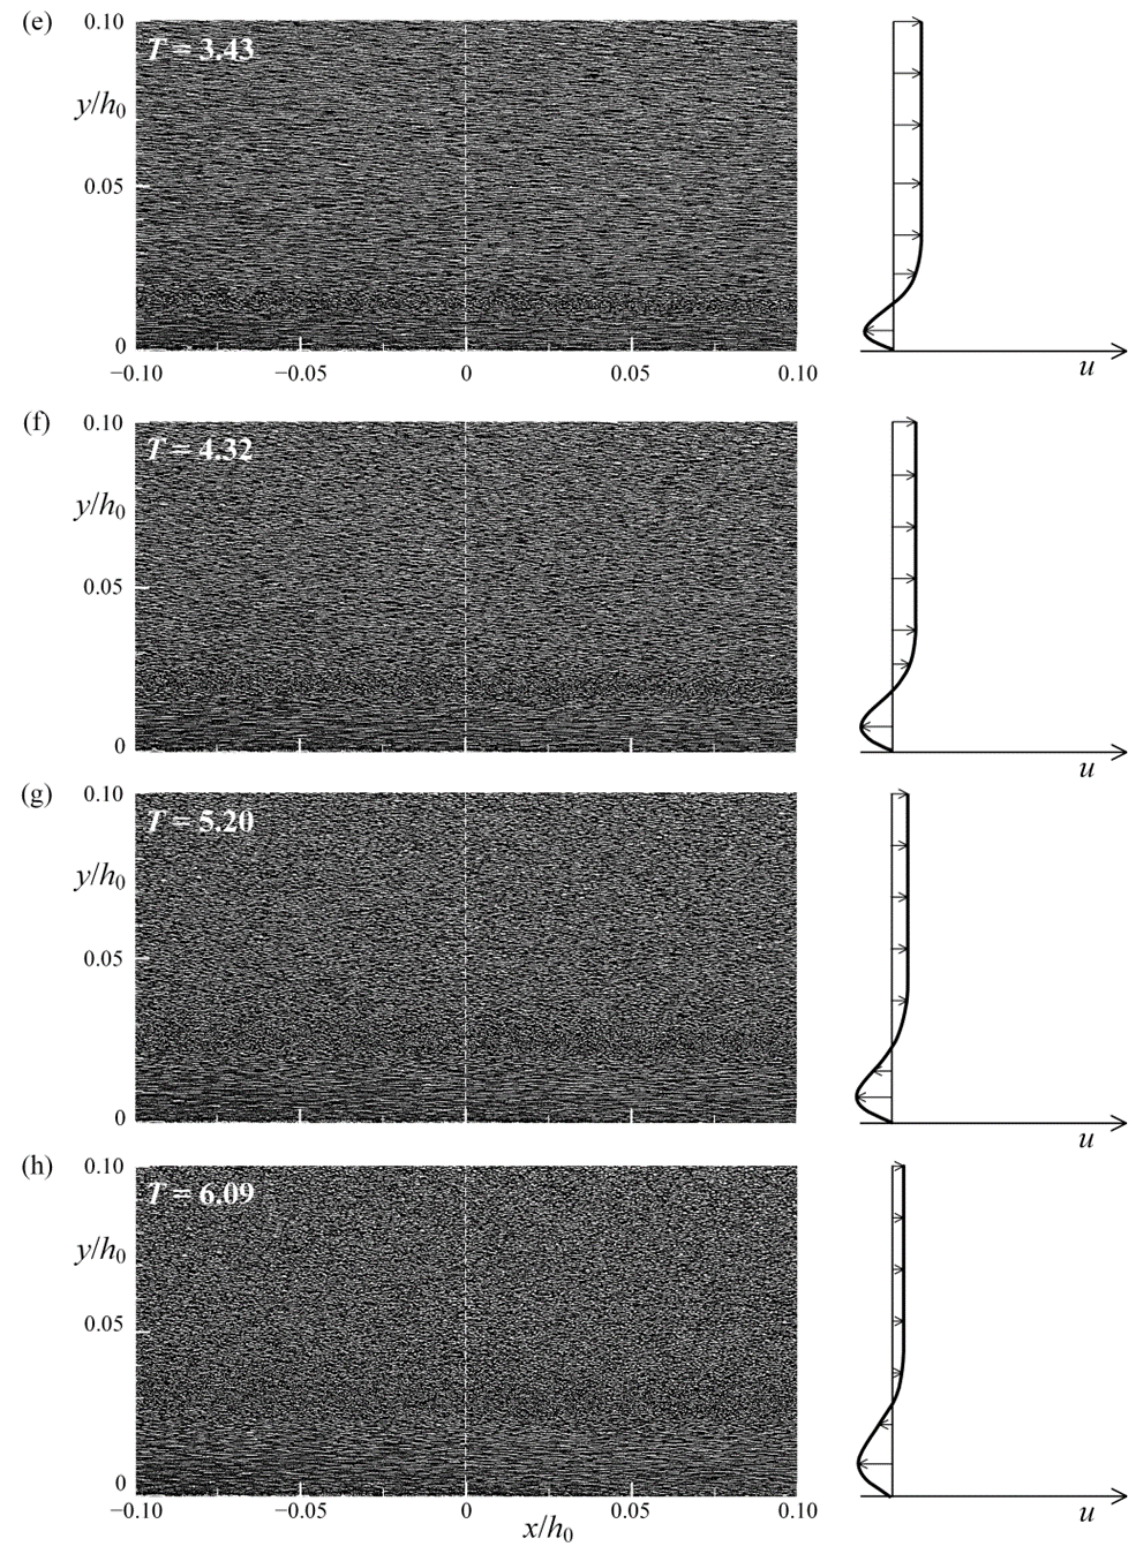
Figure 20. Flow-visualized images at T = ( a ) 0; ( b ) 0.89; ( c ) 1.67; ( d ) 2.55; ( e ) 3.43; ( f ) 4.32; ( g ) 5.20; ( h ) 6.09 for − 0.10 ≤ x/h 0 ≤ 0.10 and 0 ≤ y/h 0 ≤ 0.10.